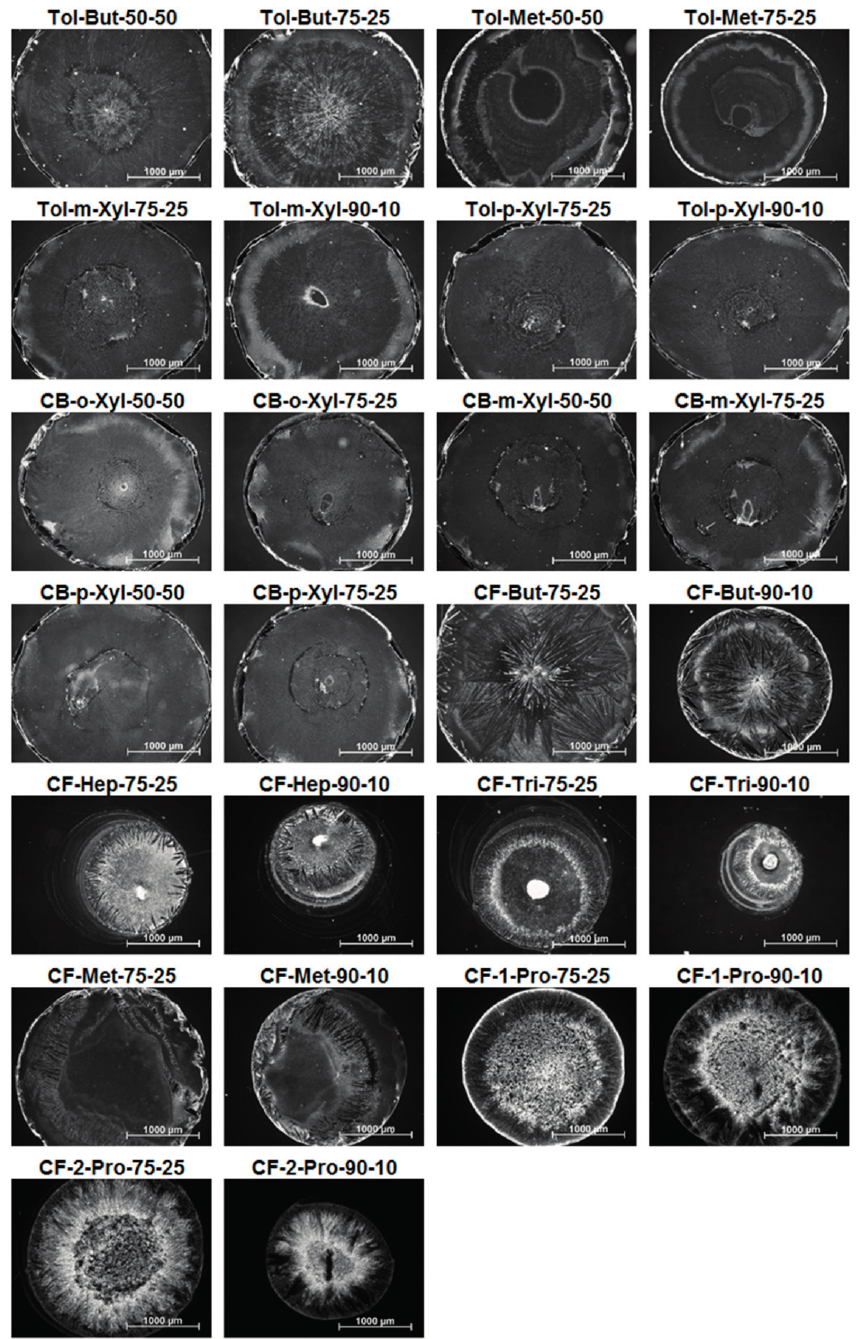
Figure 2. Dark field microscope images of the drop crystallization in each of the 26 solvent mixtures as specified in Table